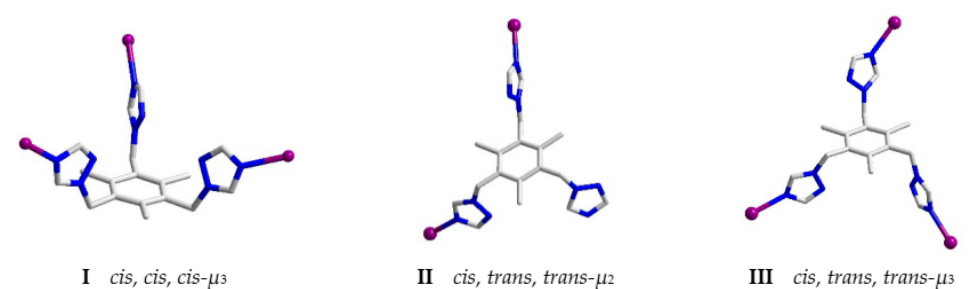
Figure 4. The different conformations of ligand tttmb in complexes.